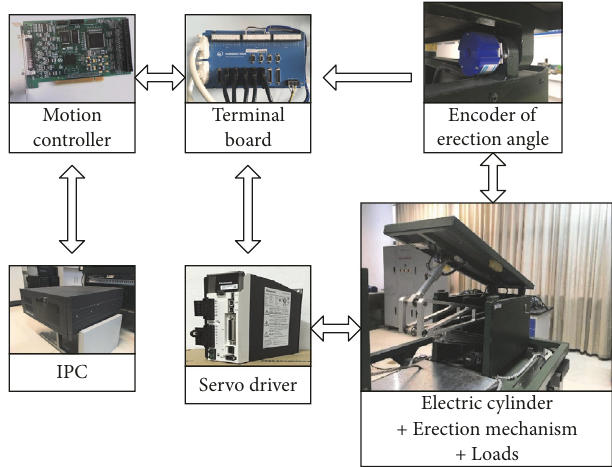
Figure 1: Composition of the electric erection system.